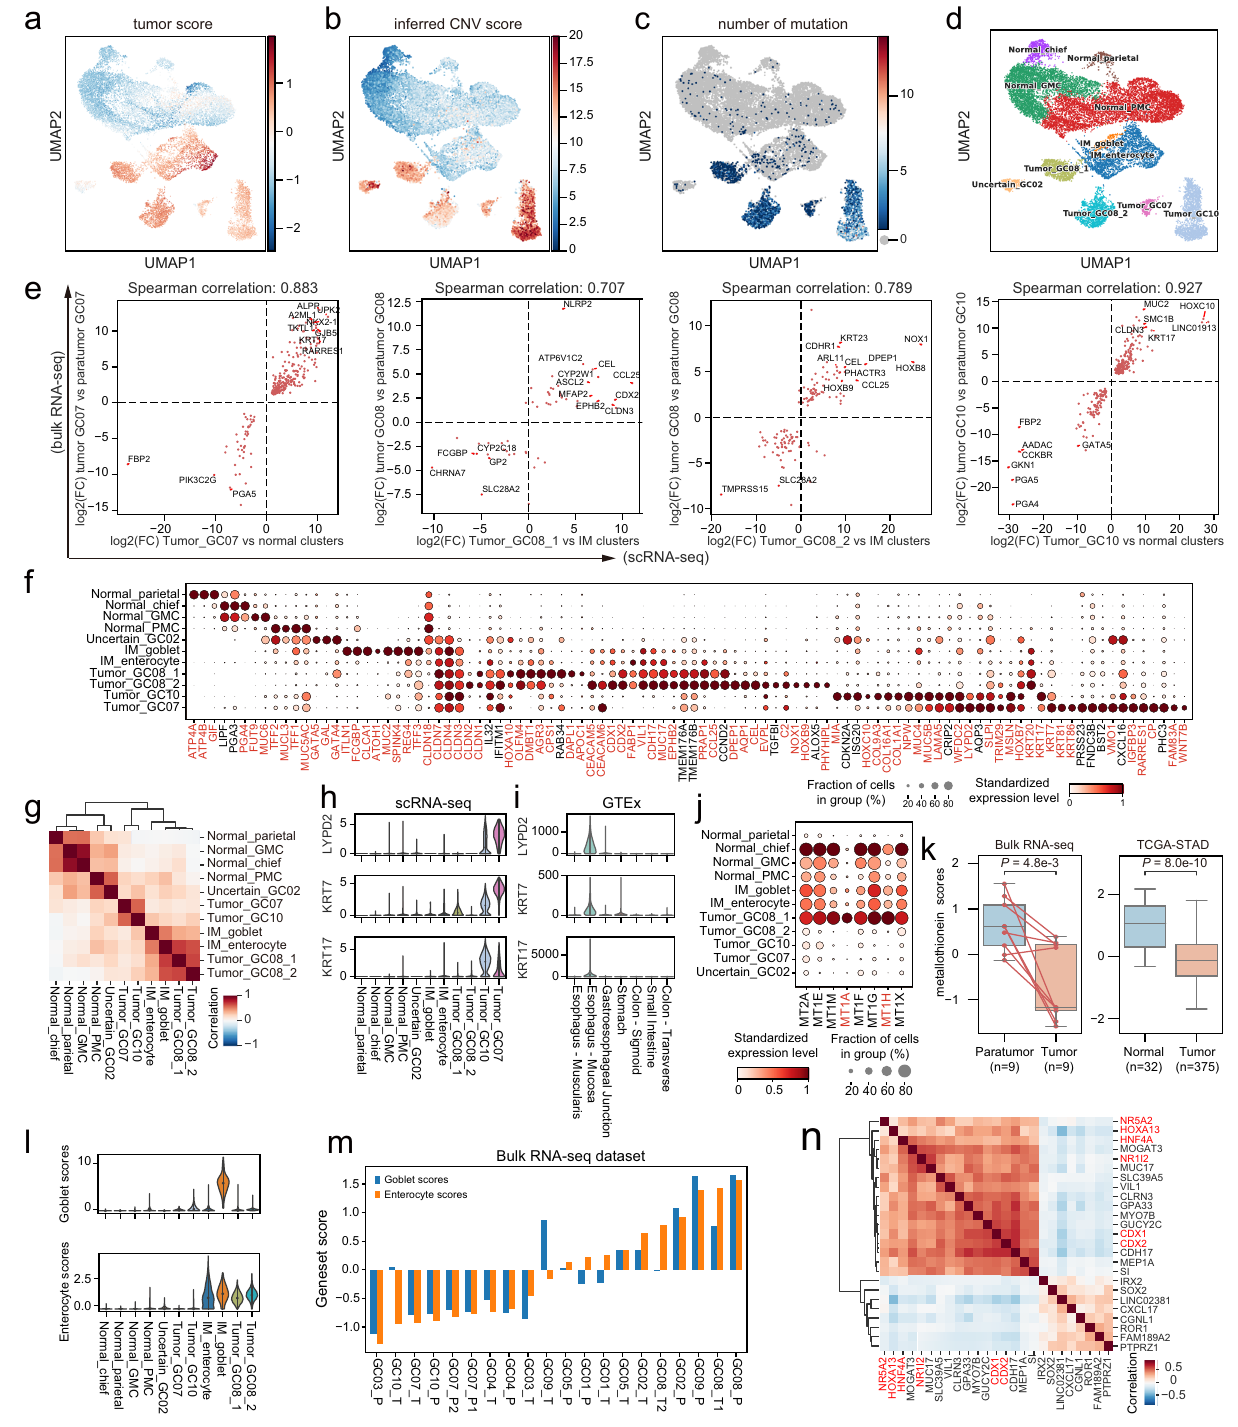
discussed in later sections (Supplementary Fig. 1f).